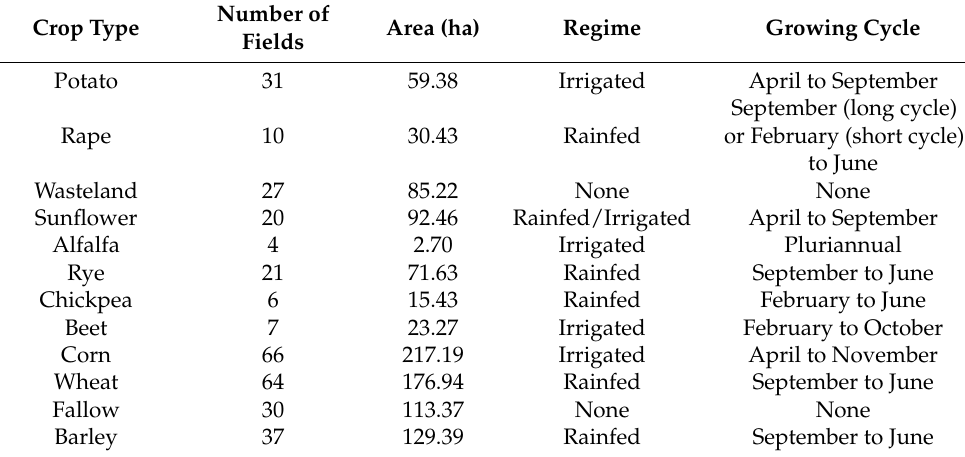
Table 1. Ground-truth dataset for classification purposes.